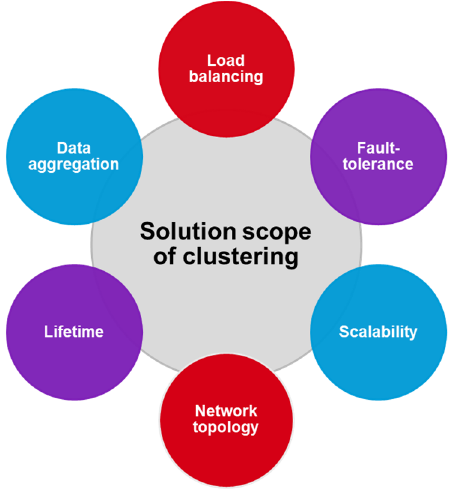
Figure 4. WSN clustering objectives.